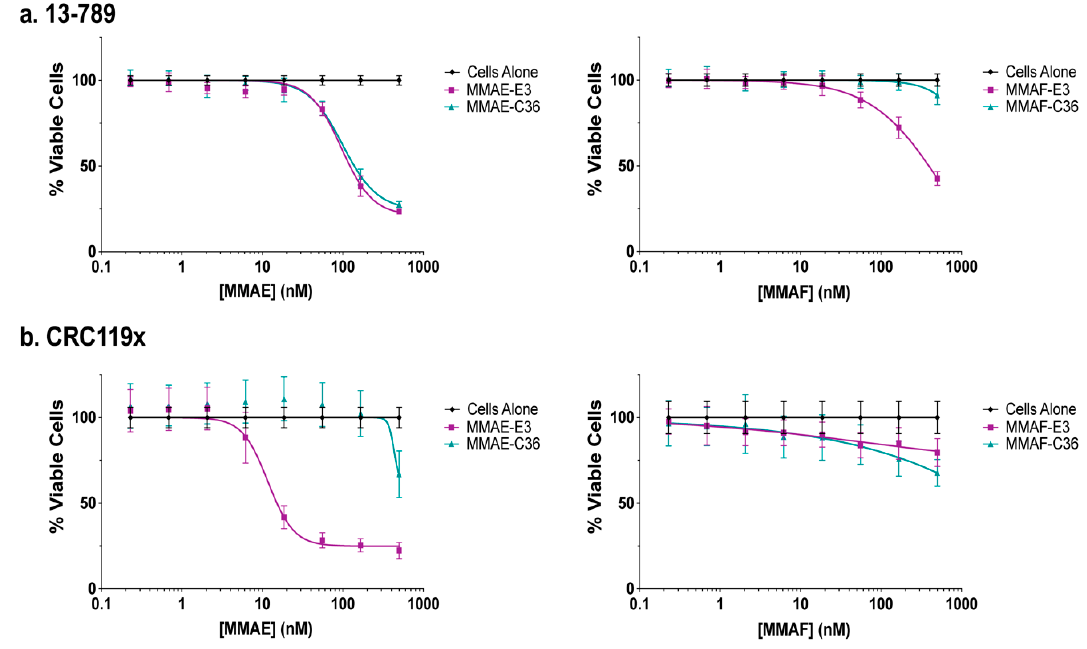
Figure 5. E3 MMAE and MMAF induce cell death in PDX-derived cancer cells. ( a ) Viability of 13-789 renal cancer PDX-derived cells and ( b ) CRC119x colorectal cancer PDX-derived cells. Cells were incubated with increasing concentrations of ApTDCs, and viability was determined at 144 h.